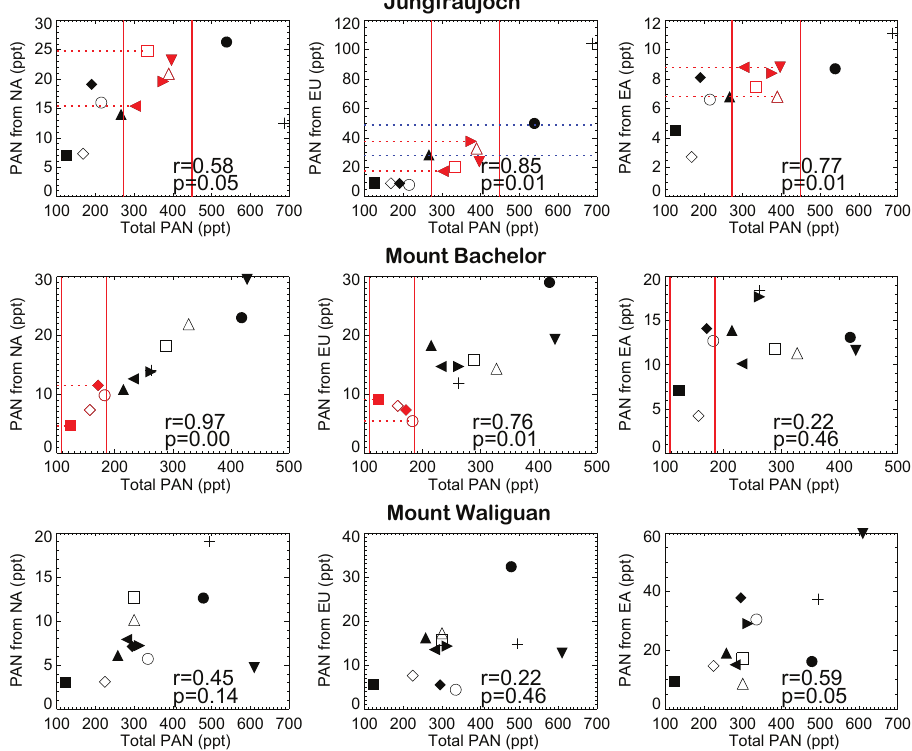
Figure 4. Simulated total PAN versus source–receptor relationships (SRRs) at each of three northern midlatitude sites. For Jungfraujoch and Mount Bachelor, vertical red lines bound the observed range in total PAN. For source–receptor pairs with significant correlations ( p ≤ 0 . 05), models falling within the observed range (across years) are colored red, and horizontal red dashed lines extend to the ordinate, representing the emergent constraint (narrower range resulting from selecting only those models falling in the observed range of total PAN). At Jungfraujoch, the range (across years) in PAN attributed to the EU source region by back-trajectory analysis (Pandey Deolal et al., 2013) is indicated by horizontal dashed blue lines. Individual models are denoted by the symbols defined in Table